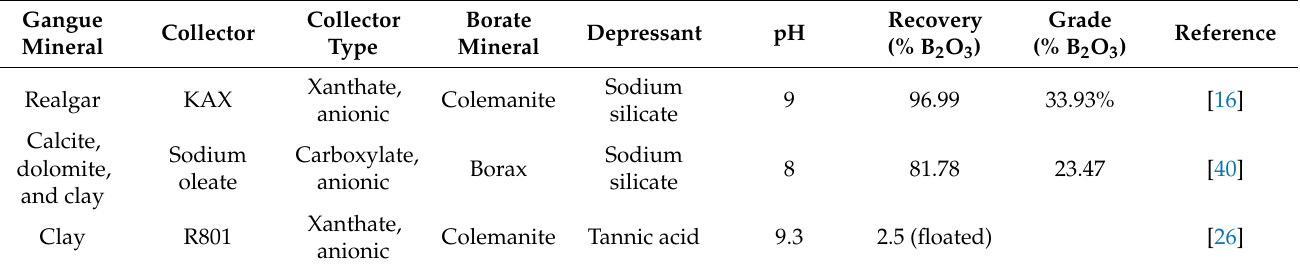
Table 6. Flotation conditions for the reverse flotation of